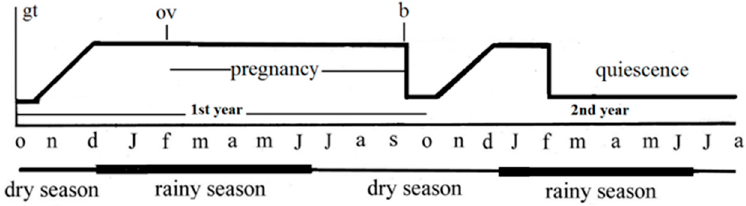
Figure 1. Schematic representation of the biennial sexual cycle in the Typhlonectes compressicauda female. The first year is devoted to the pregnancy, and the genital tract is quiescent in the second year. gt: variations of genital tract; ov: ovulation; b: birth. The first letter of each month is given on the abscissa.